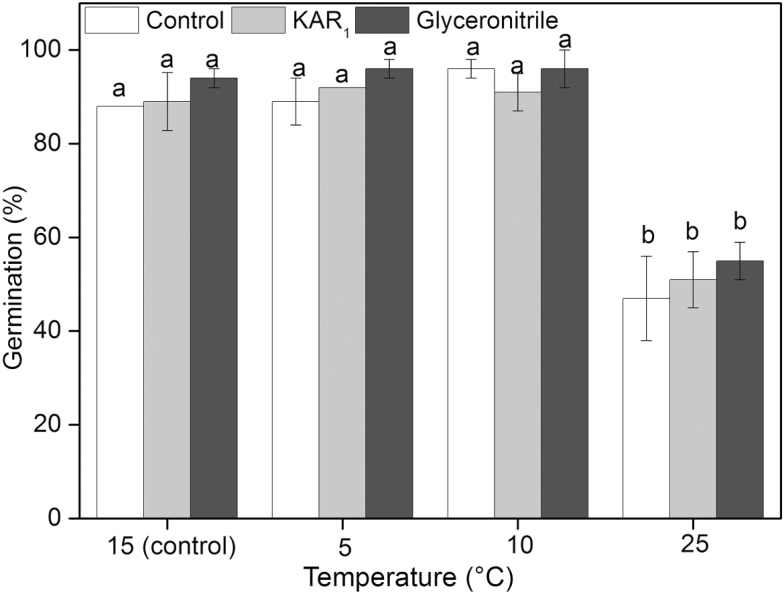
Mean germination (% ± SE) of after-ripened Anigozanthos flavidus seeds cold stratified (5 °C, 10 °C) or warm stratified (25 °C) for 4 weeks in water, KAR1 or glyceronitrile and then moved to 15 °C for an additional 4 weeks with seed germination at 15 °C as control. Before movement, no germination occurred at 5, 10 and 25 °C. Different letters indicate significant differences (P < 0.05) between mean germination time across all treatments.